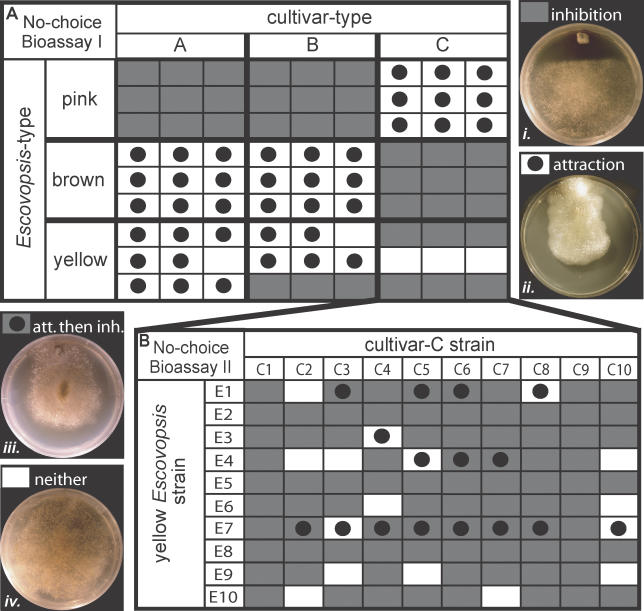
No-Choice BioassaysEach cell represents the outcome of the interaction between one cultivar and one
Escovopsis isolate. Gray indicates inhibition (i), a dot indicates attraction and subsequent infection (ii), gray with a dot indicates attraction followed by inhibition (iii, note that the cultivar is not overgrown), and white indicates neither attraction nor inhibition (iv).
(A) No-choice bioassay I. Interaction between three isolates of cultivars A, B, and C and three isolates of each of the
Escovopsis morphotypes.
(B) No-choice bioassay II. Interaction of ten yellow
Escovopsis isolates confronted with ten cultivar-C isolates. These 100 bioassays are a more exhaustive dataset corresponding to the nine yellow
Escovopsis–cultivar C trials in no-choice bioassay I.